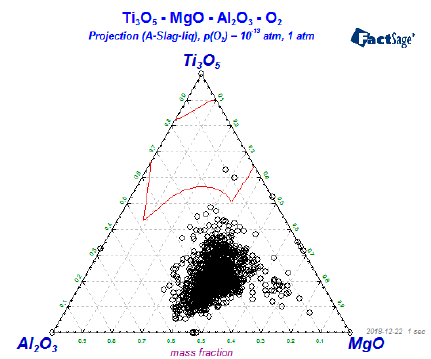
Figure 4. Composition distributions of inclusions in the Al 2 O 3 –MgO–Ti 3 O 5 phase diagram under P O2 = 10 − 13 atm. Dotted lines represent the liquidus line (1873 K).